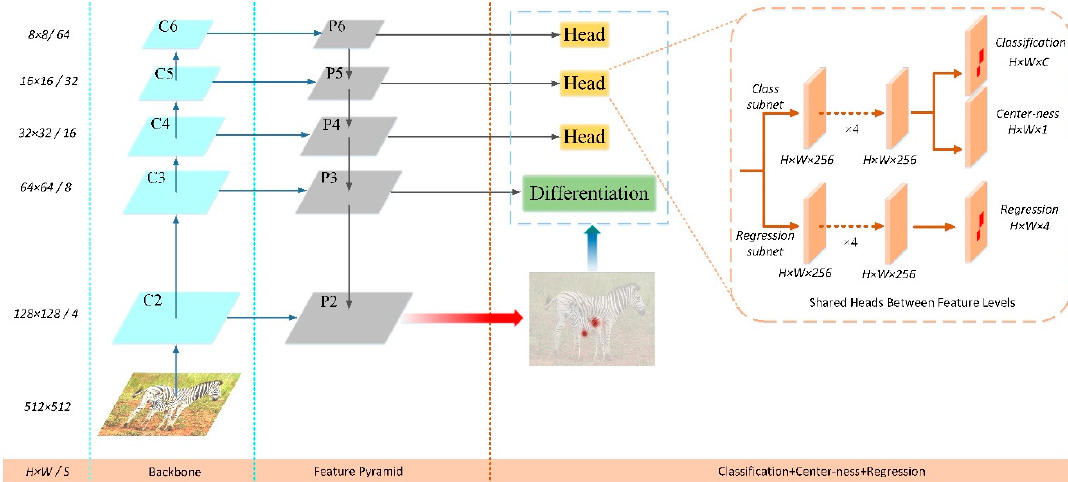
Figure 4. The network architecture of model C2–C6 denote the feature maps of the backbone network and P3-P6 the feature levels used for the final prediction. P2 is used to generate keypoint heatmap. Differentiation means differentiation module, and H × W the height and width of feature maps. ‘/s’ (s = 4, 8, 16, ..., 64) is the down-sampling ratio of the level of feature maps to the input image. All the numbers are computed with an input of 512 ×